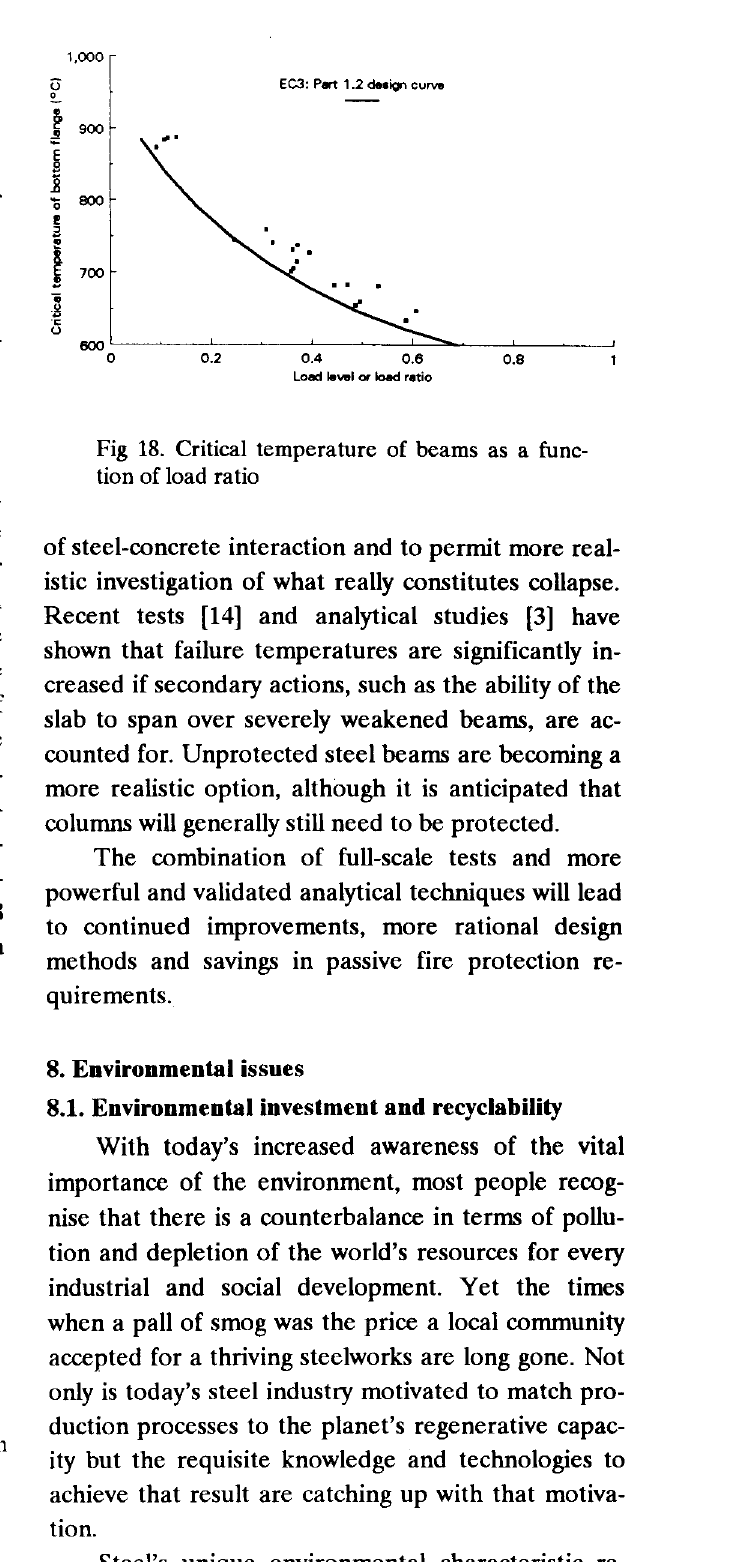
Fig 17. Critical temperature of columns as a function of load ratio